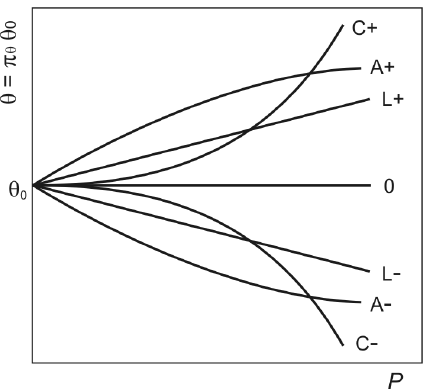
Figure 5. Possible variations of a parameter ( h ) of the response to an effector, as a function of the concentration of a perturbator ( P ). Any of the functions (19), (20) and (21) can produce all the profiles. Parametric value can be increased ( + ) or decreased ( 2 ), with constant (L), decreasing (A) or increasing (C) slope.